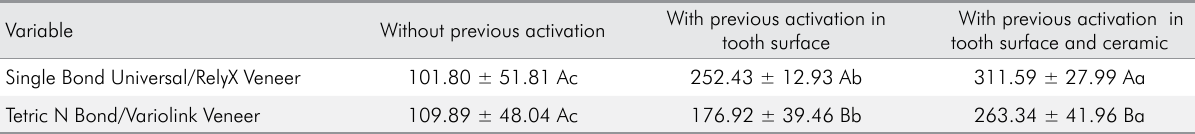
Table 2. Mean ± standard deviation of luting interface thickness of ceramic laminate veneers (μm) as function of luting protocol and luting agent